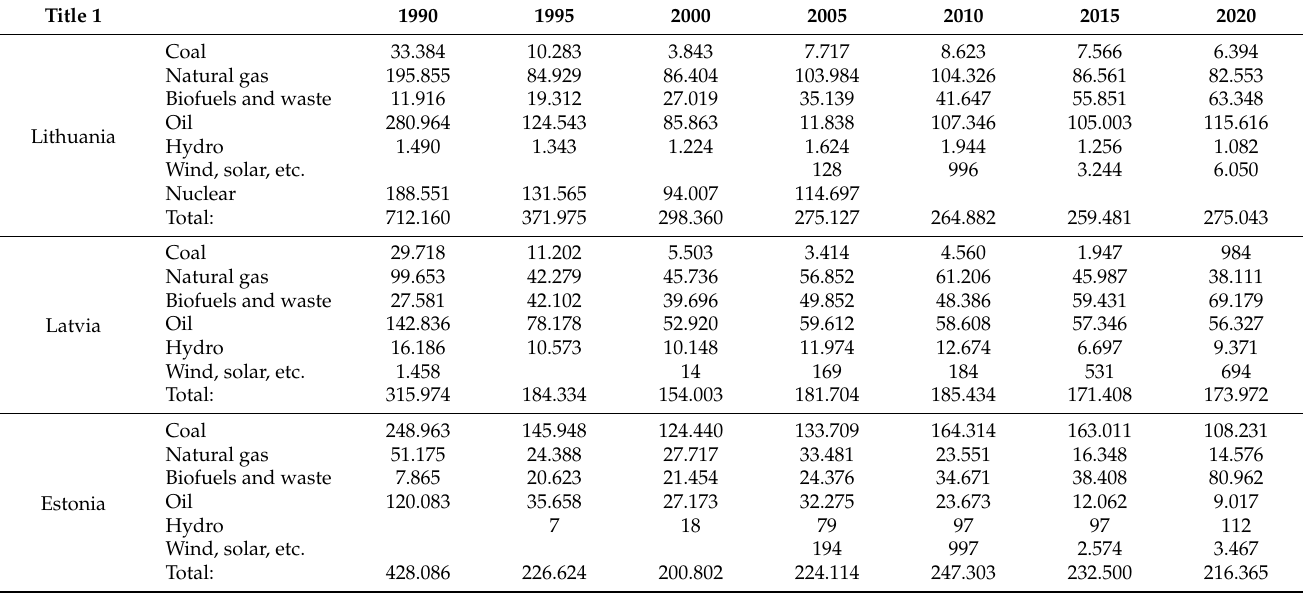
Table A2. Total annual energy supply by source in Lithuania, Latvia, and Estonia 1990–2020 (in